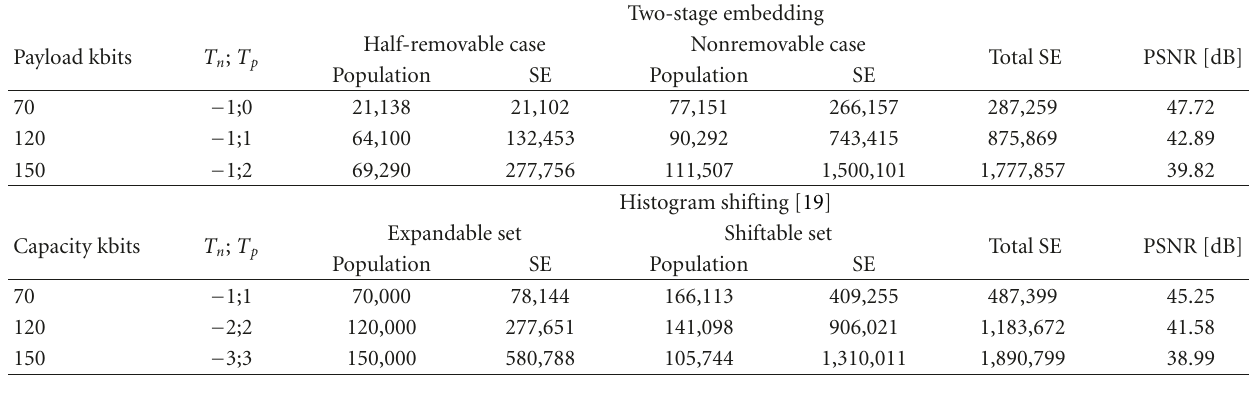
Table 1: Populations of cells from di ff erent scenarios and sets versus di ff erent capacities for Lena image.